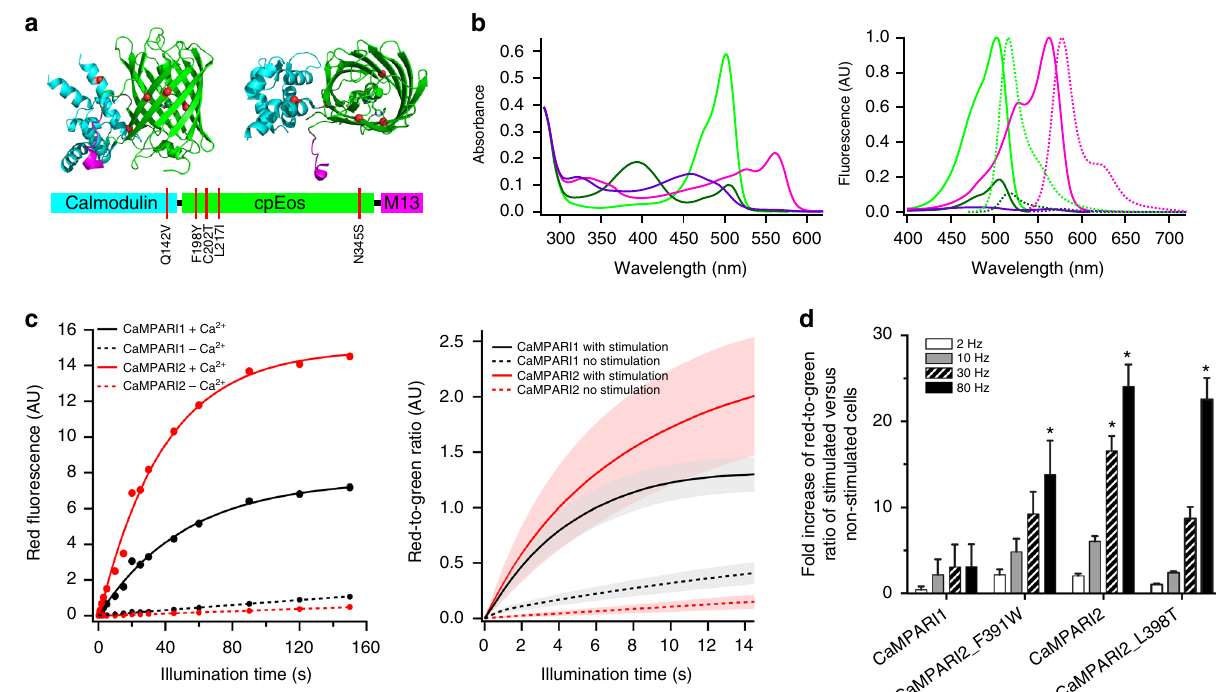
Fig. 1 In vitro characterization of CaMPARI2. a Primary (bottom) and tertiary (top) structures of CaMPARI2. Mutations relative to CaMPARI1_W391F- V398L are shown in red. Two orthogonal views of the same CaMPARI crystal structure (PDB ID 4OY4 [https://doi.org/10.2210/pdb4OY4/pdb] are shown. b Absorption (left) and fl uorescence (right) excitation (full line) and emission (dotted line) spectra of CaMPARI2. Green and magenta spectra represent the green and red forms of CaMPARI; bright and dark lines represent the calcium-free and calcium-saturated states. c Photoconversion timecourse showing the red fl uorescence of CaMPARI1 (black) and CaMPARI2 (red) as a function of exposure to 405 nm light. Left: photoconversion of puri fi ed CaMPARI protein in the presence (solid lines) or absence (dashed lines) of calcium. Right: photoconversion of primary rat hippocampal neurons with (solid lines) or without (dashed lines) 80 Hz stimulation. d Fold increase of the red-to-green ratio of CaMPARI variant-expressing neurons after 2 s of photoconversion during different electrical stimulation frequencies relative to no stimulation. Error bars are standard deviation, n = 3, asterisks denote values signi fi cantly differing from the corresponding CaMPARI1 value ( p < 0.001, Dunnett ’ s multiple comparisons test)